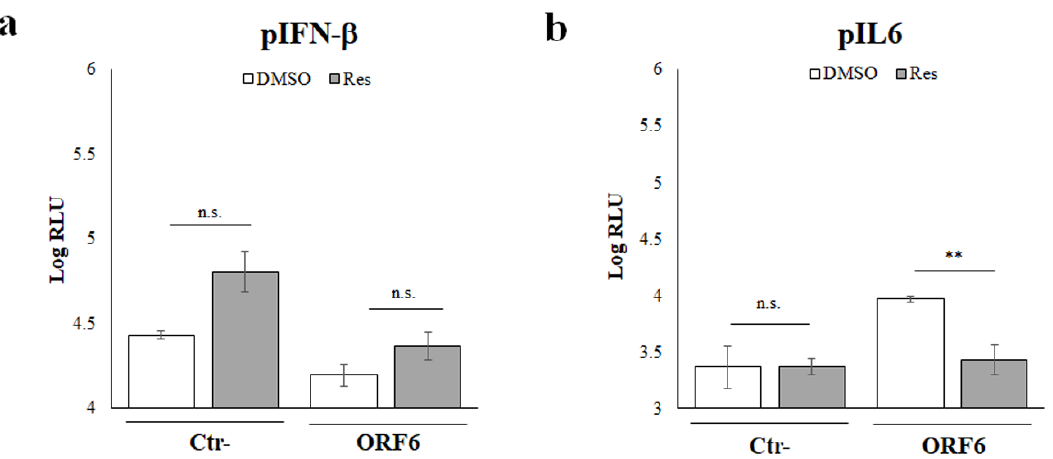
Figure 4. The NF- κ B inhibitor Resveratrol is effective on ORF6 activity. HEK-293T cells were co- transfected with the IFN- β ( a ) and interleukin-6 ( b ) promoter-mediated firefly luciferase and the SV40 promoter-mediated Renilla luciferase reporter plasmids. Where indicated, empty plasmid (Ctr-) or ORF6 protein was ectopically expressed by transfection. At 24 h post transfection, cells were treated with 10 µM of resveratrol or with vehicle (DMSO) for additional 24 h. Firefly and Renilla luciferase activities were determined. Three ( n = 3) independent experiments were performed and representative data are presented as mean logarithm values of relative luminescence unit (RLU) ± standard deviations. Significance was evaluated as p < 0.05 (** p < 0.005, , n.s. not significant).